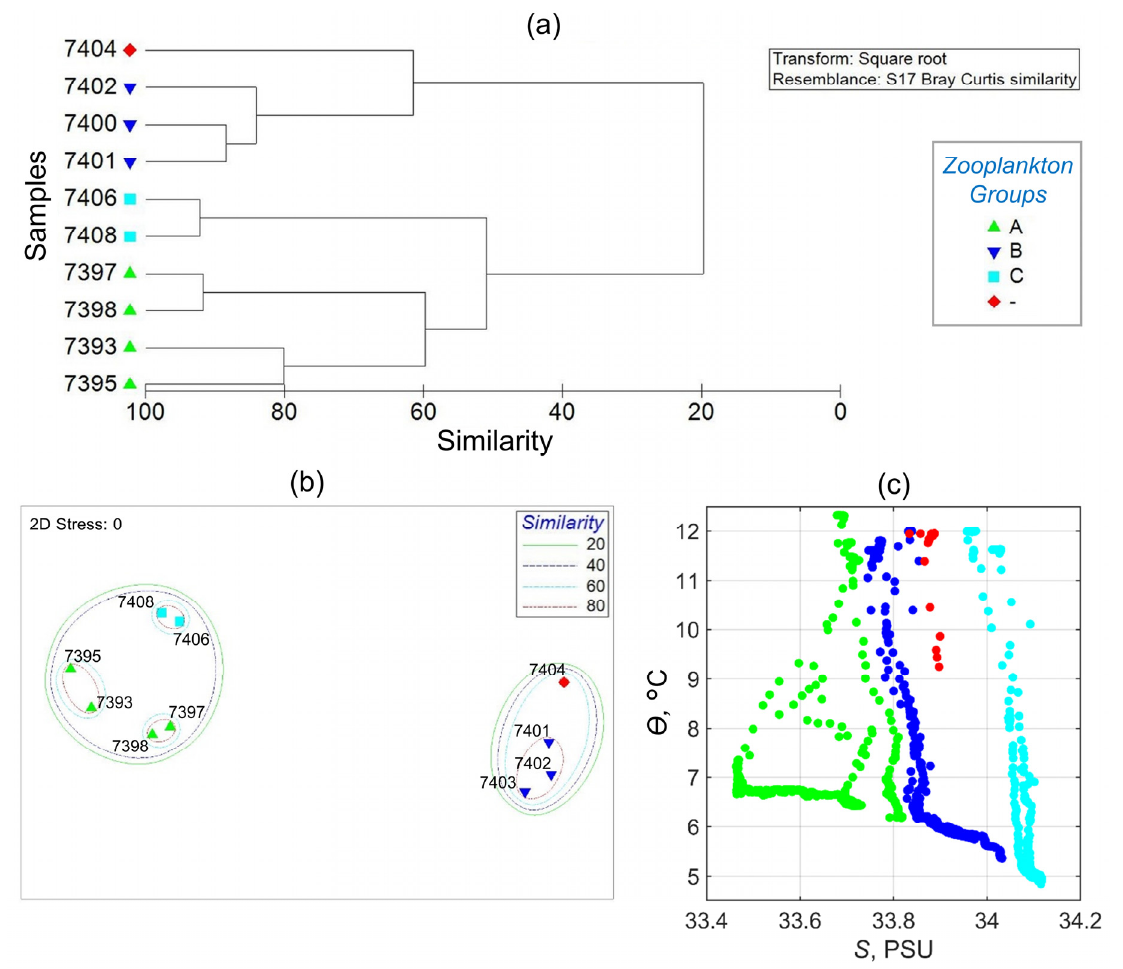
Figure 11. Cluster ( a ) and MDS ( b ) analyses of zooplankton collections (by species abundance), and θ - S scatter plot, where the colors of points correspond to the groups in ( a – c